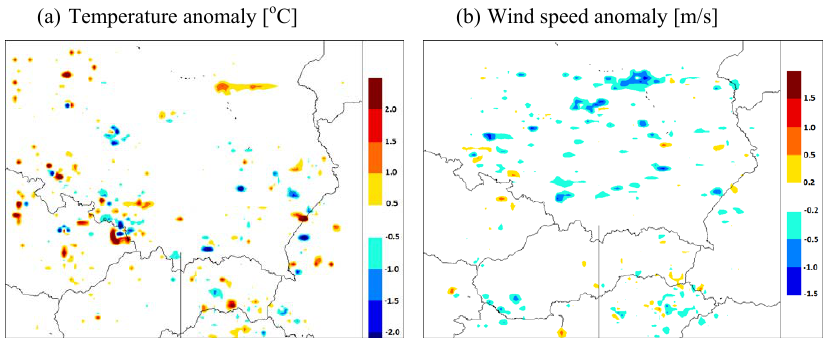
Figure 7. Temperature (a) and wind speed (b) anomaly calculated as the difference between urban and non-urban scenarios – 3 January 2011, 12:00UTC.